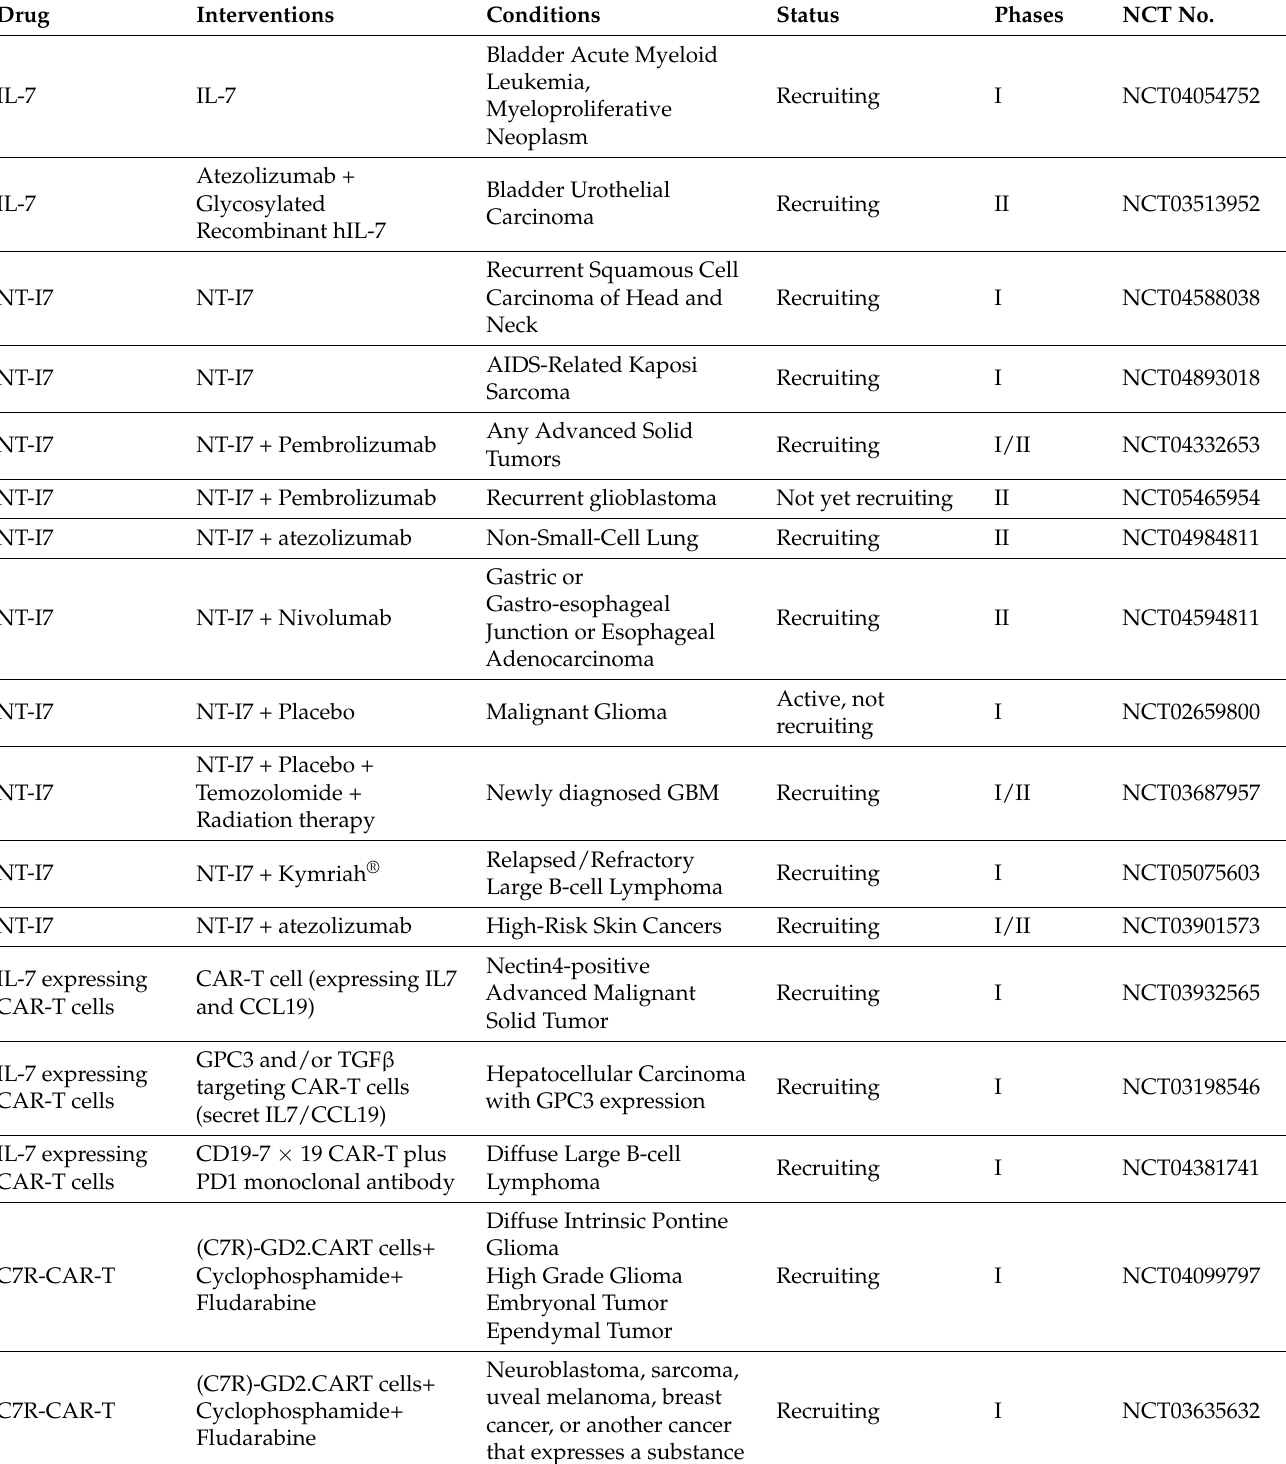
Table 1. Examples of ongoing clinical trials with IL-7 and IL-7R in cancer